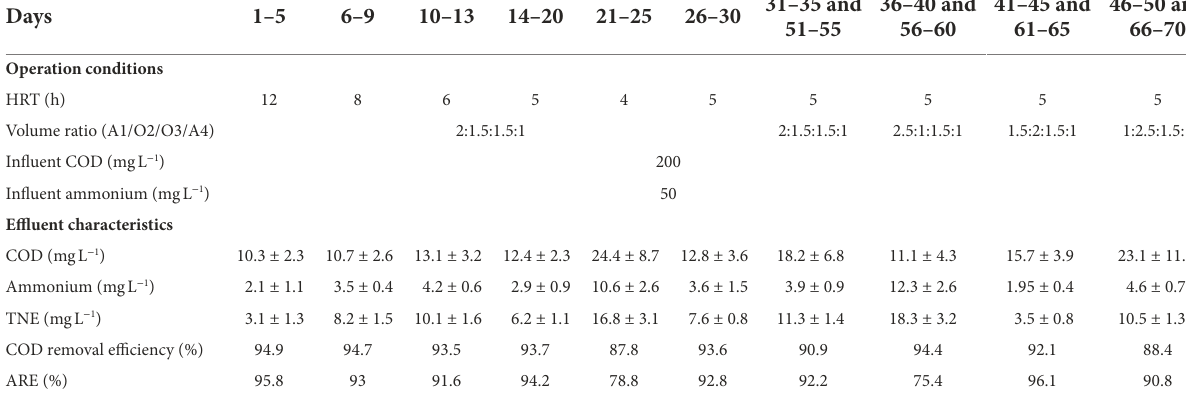
TABLE 2 Operating parameters of the reactor during period I.